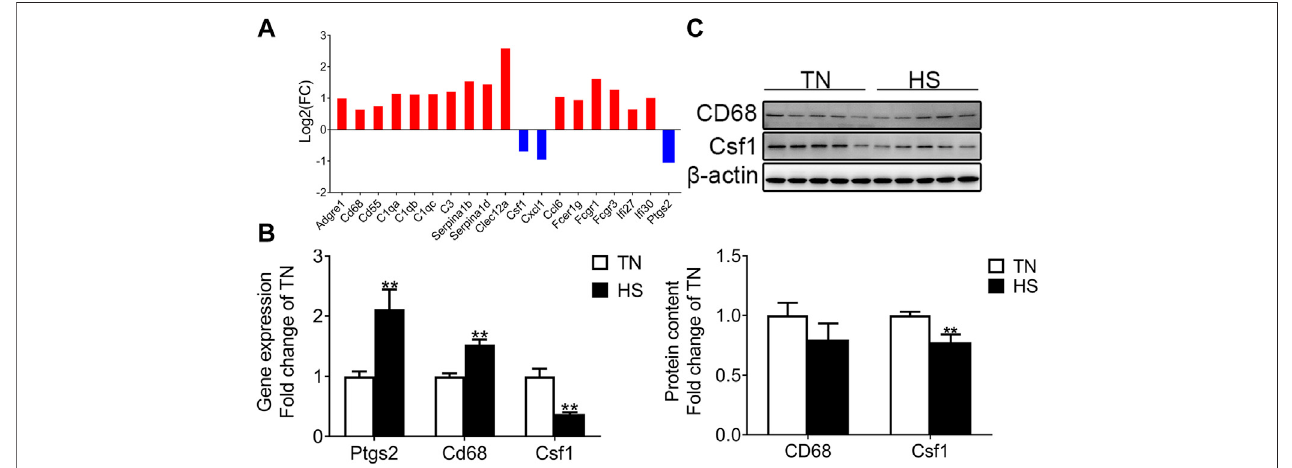
FIGURE 2 | Effects of HS during late gestation on the expression of genes enriched in immune response in the placenta. Fold change of DEGs (A) , mRNA expression (B) ,andprotein levels(TN: n =11;HS: n =8) (C) intheplacenta.Genesymbolsareshownonthex-axis,and log 2 FCisshownonthey-axis.Bluebar:down- regulation; red bar: up-regulation. Data are presented as mean ± SEM. * p < 0.05, ** p <